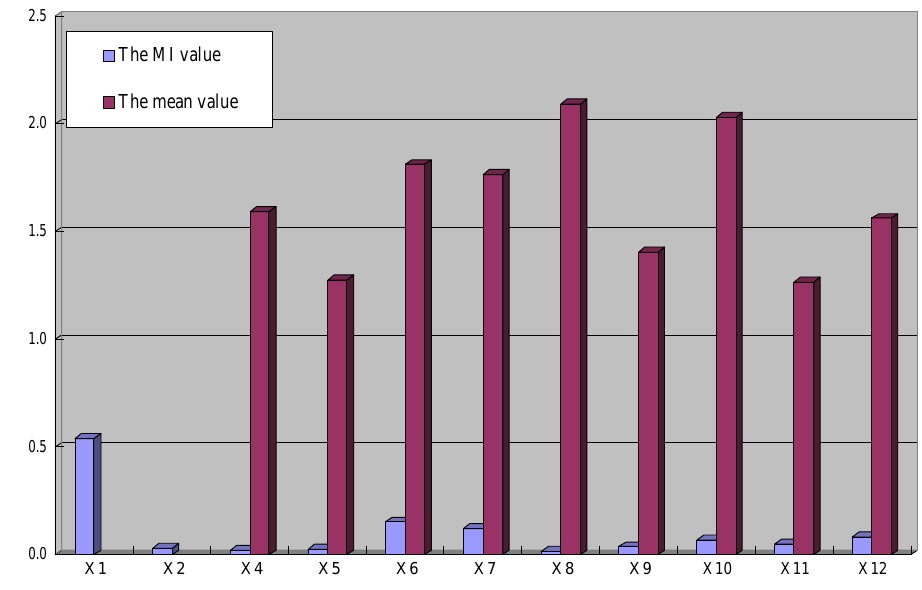
Figure 4. The MI and mean values of each deciding factor for